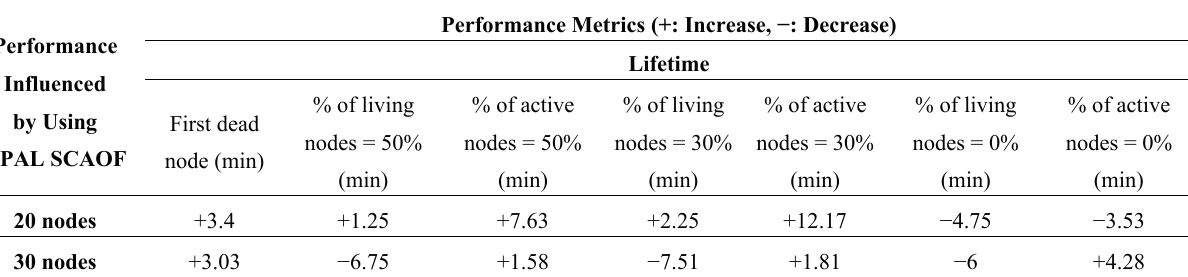
Table 7. Network lifetime of 20 and 30 LLN nodes scenarios.